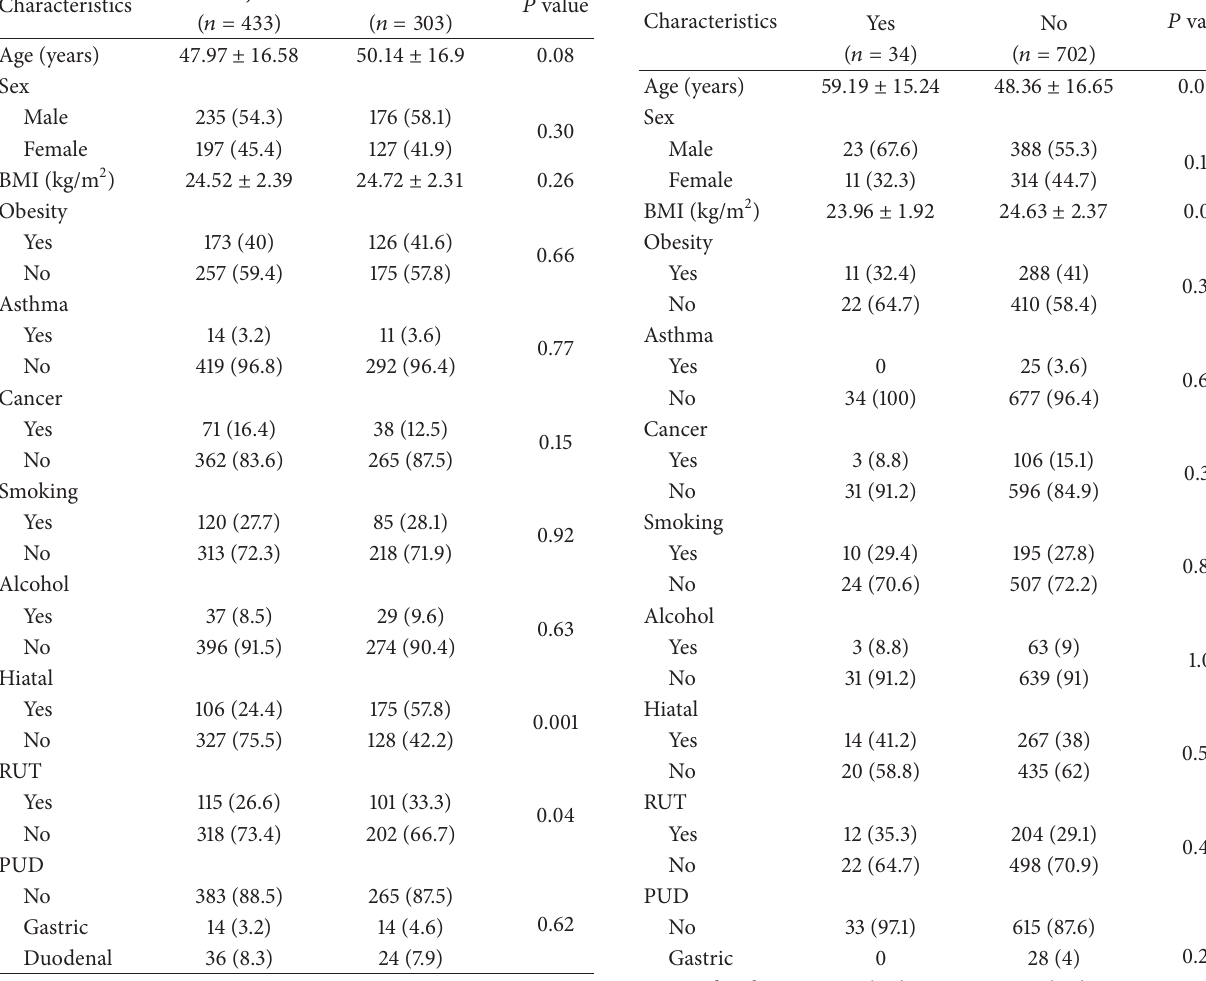
Table 1: Background characteristics of the study groups. Table 2: Background characteristics of the study groups.